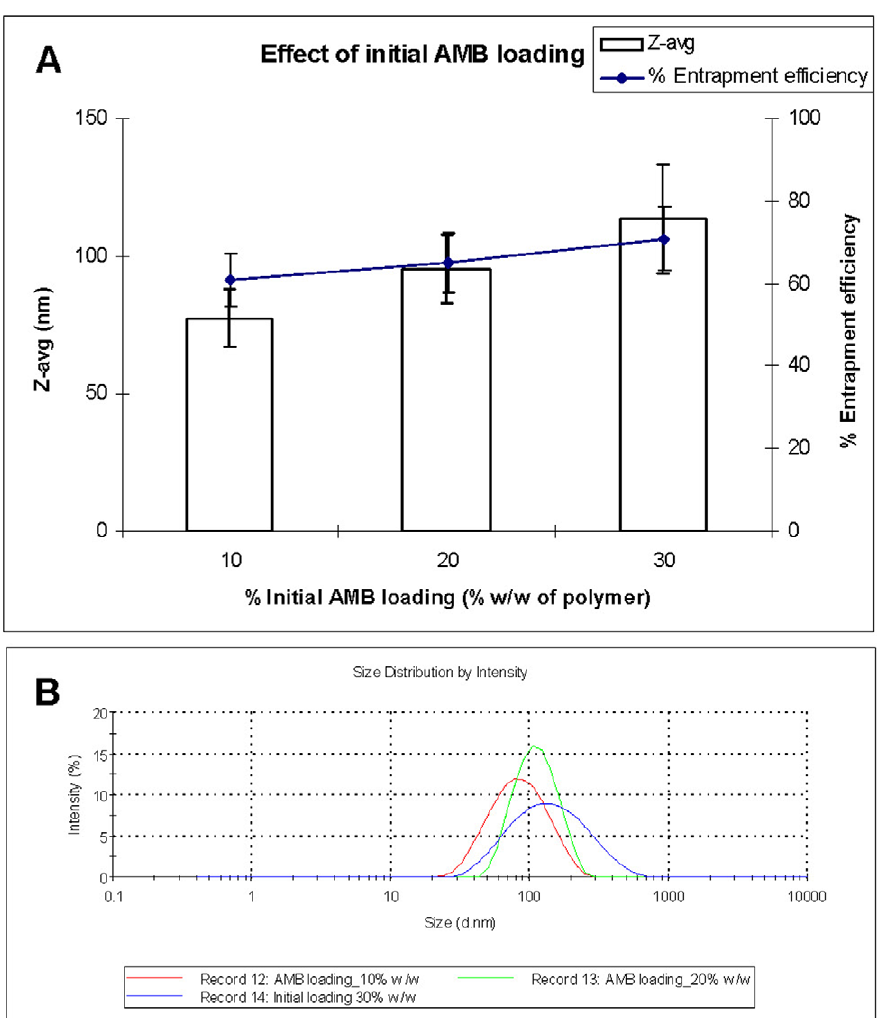
Figure 4. The effect of initial AMB loading on particle size, entrapment efficiency (A) and particle size distribution (B). PDI for 10% Loading: 0.1 6 0.01; 20%: 0.2 6 0.00; 30%: 0.2 6